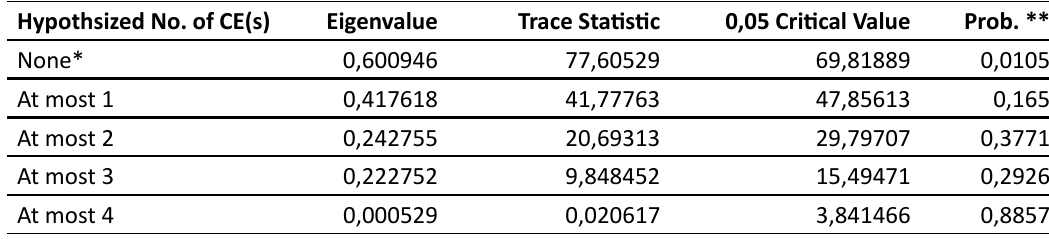
Table 4: the Johanssen Cointegration